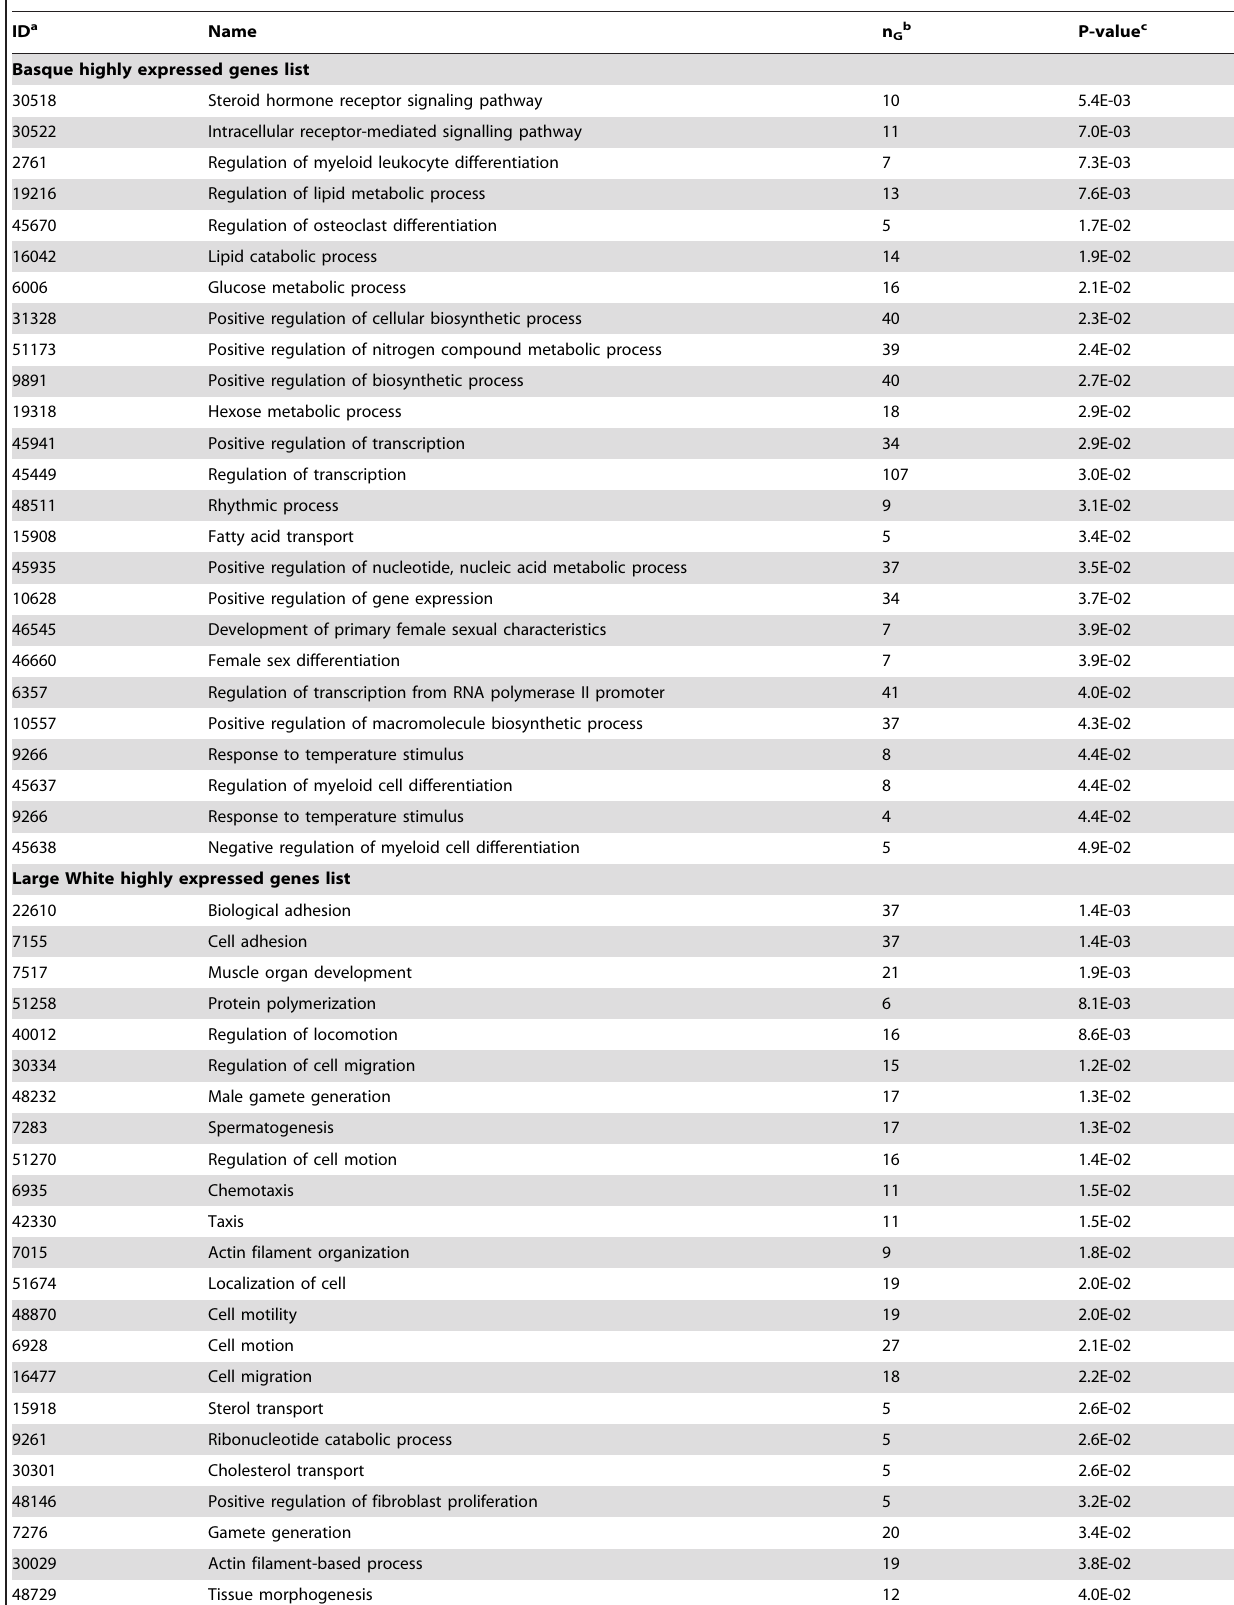
Table 4. Relevant biological processes significantly enriched in the two lists of differentially expressed genes.